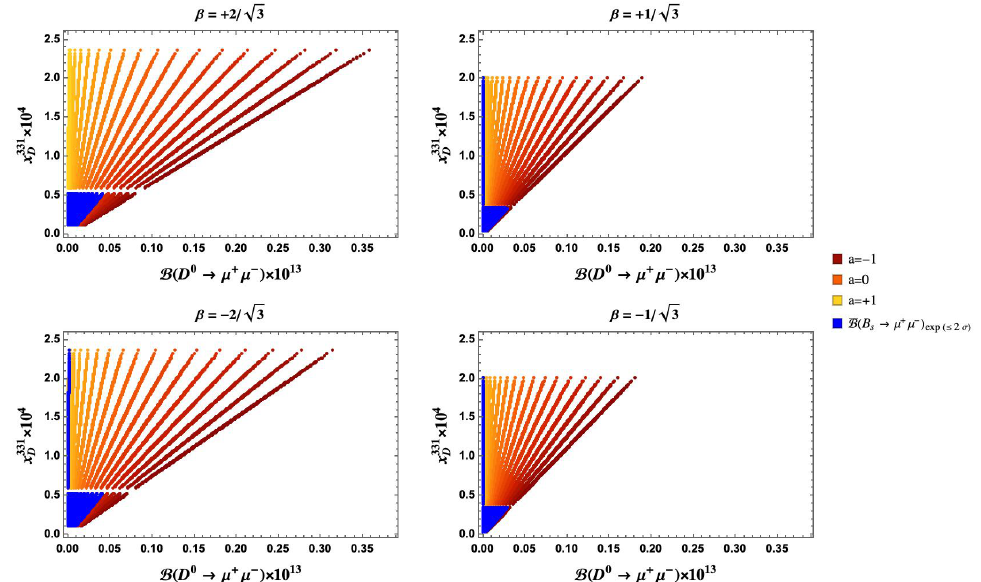
and B ( D 0 → µ + µ − ) in the four 331 variants considered in Figure 8 . Correlation between x 331 D this paper, with M = 1 TeV. The SM contribution is set to zero in both observables. The sliding Z 0 colours correspond to the variation of the Z − Z 0 mixing parameter a in eq. (2.6) in the range [ − 1 , 1] . Three of such values are indicated in the legends. The blue points are obtained imposing that B ( B + µ − ) lies in the experimental range within 2 σ s → µ